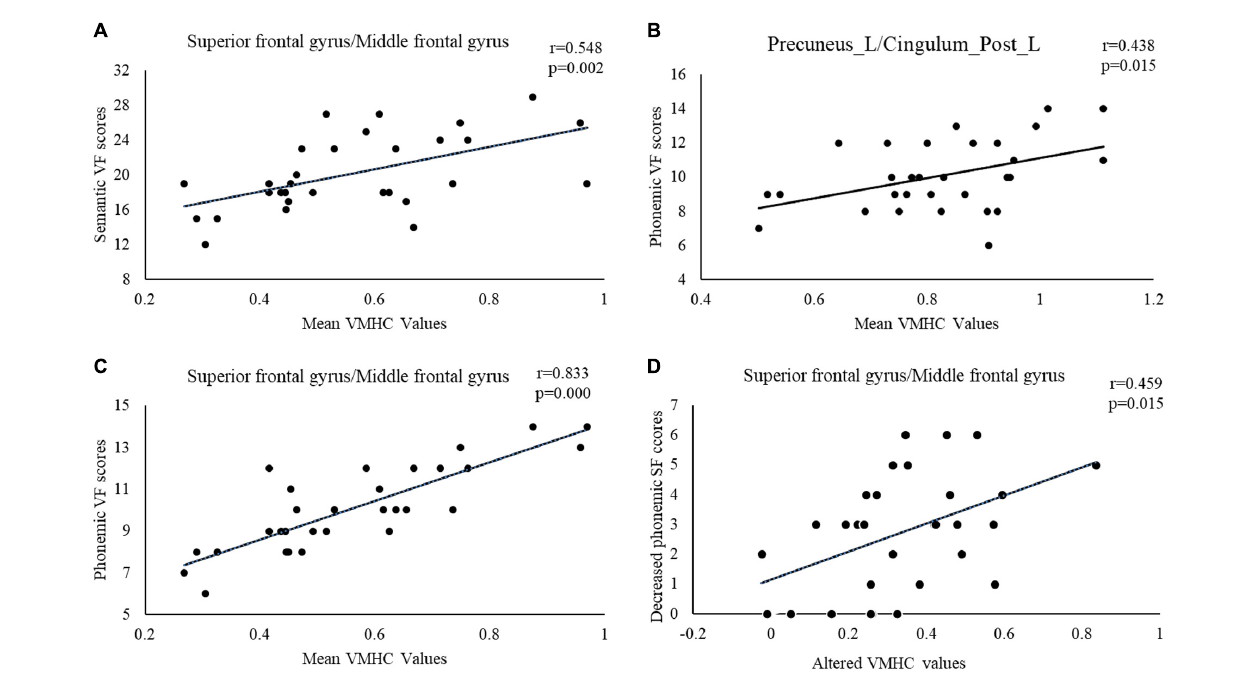
FIGURE 2 | The correlations between VF scores and mean VMHC values in brain regions with statistically significant differences between PD patients before and after surgery. Relationships between: (A) Semantic VF and mean VMHC value of superior frontal gyrus and middle frontal gyrus, (B) Phonemic VF and mean VMHC value of precuneus/posterior cingulate gyrus, (C) Phonemic VF and mean VMHC value of superior frontal gyrus and middle frontal gyrus, and (D) Decreased phonemic VF and altered VMHC value in the superior frontal gyrus and middle frontal gyrus. VMHC, voxel-mirrored homotopic connectivity; VF, verbal